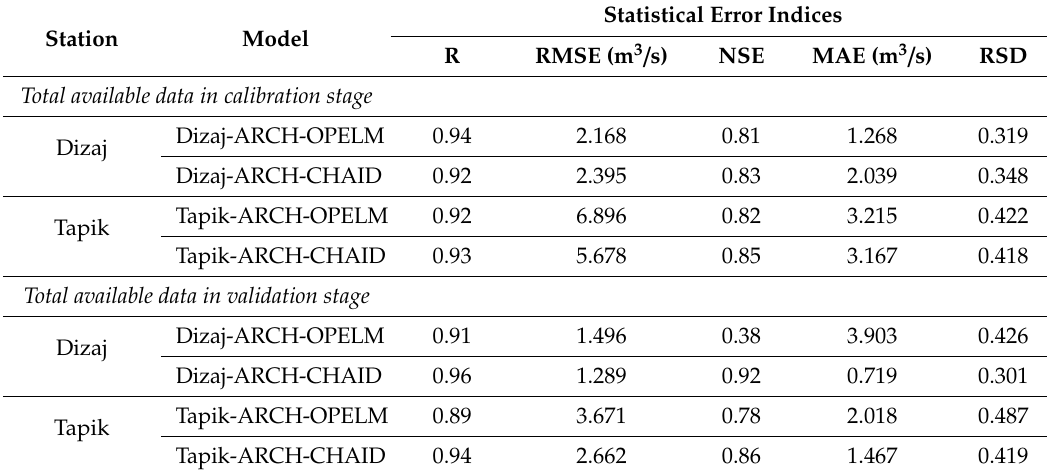
Table 6. Performance results of hybrid ARCH-OPELM and ARCH-CHAID models for Dizaj and Tapik